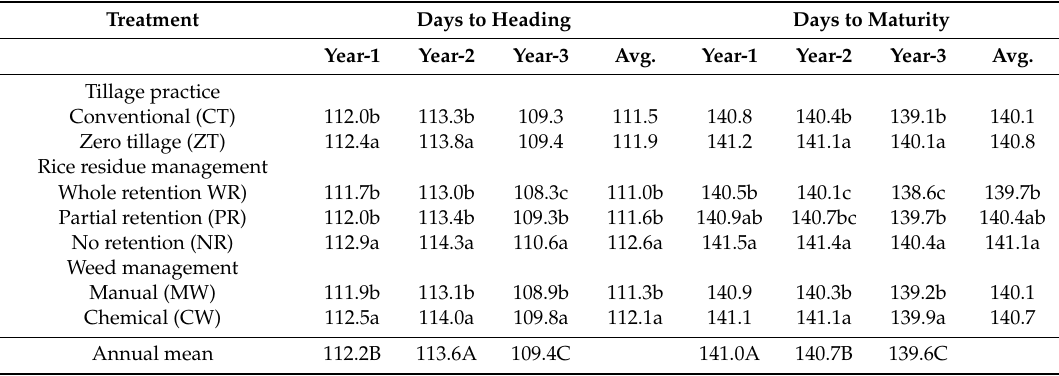
Table 3. Days to heading and physiological maturity of rice under di ff erent tillage, crop residue and weeding managements. Di ff erent lowercase letters within a column indicate significant di ff erence with a treatment. Di ff erent uppercase letter within a row for annual mean values (last row) indicate significant di ff erence among the study